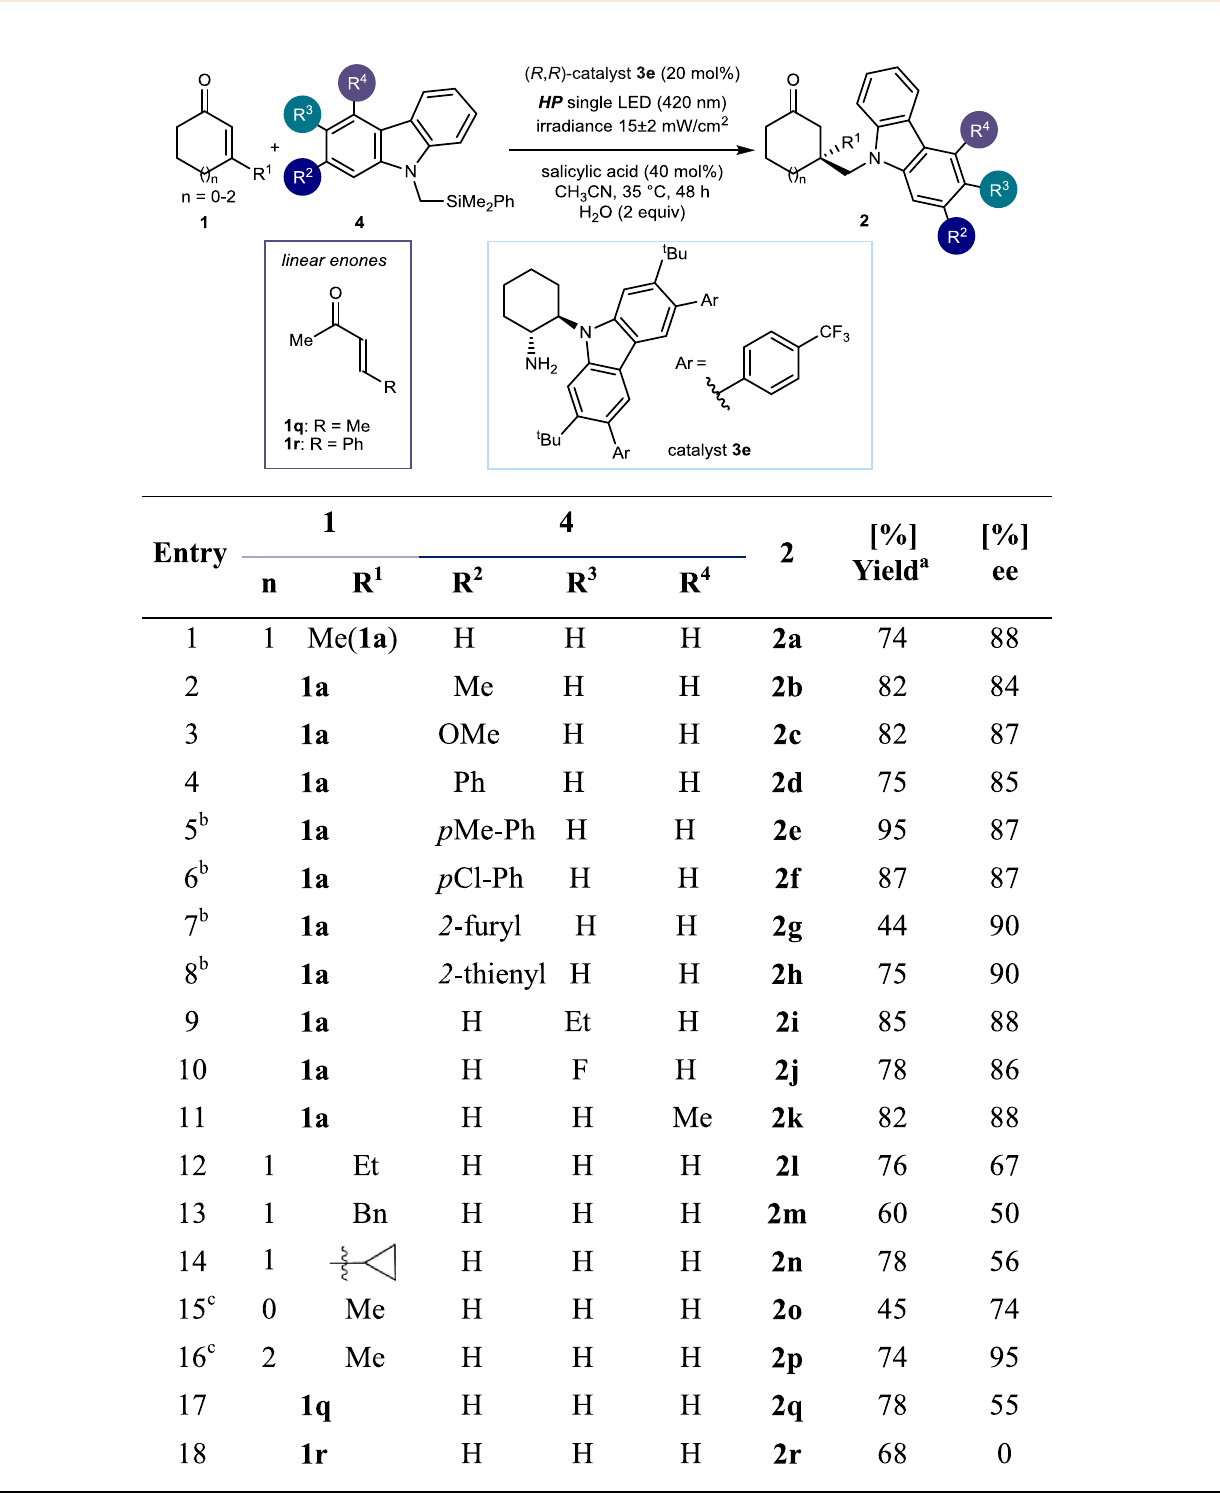
Table 2 Substrate scope for the enantioselective trap of carbazole-derived